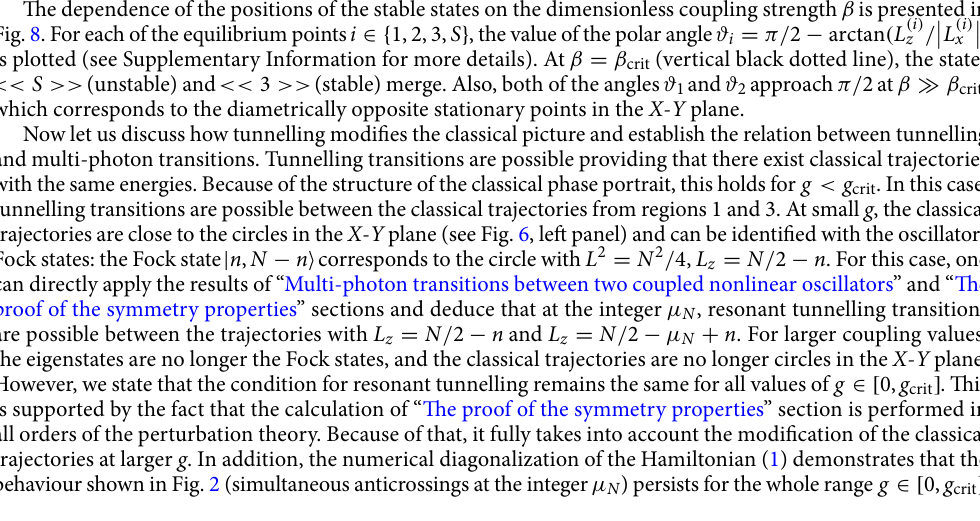
β crit (vertical black dotted line), the states =